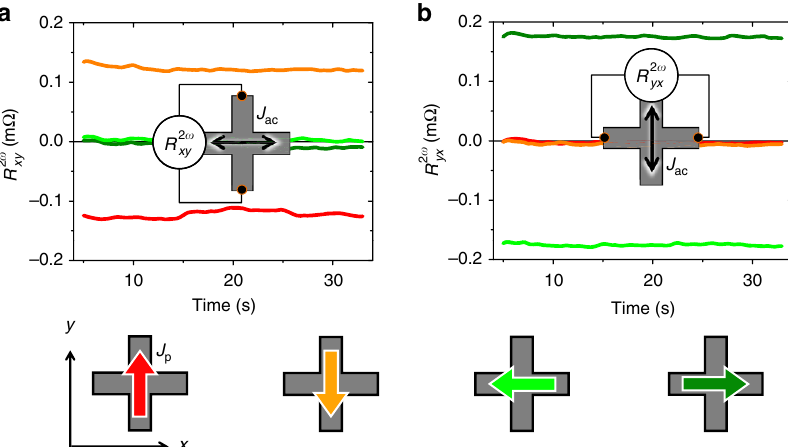
Fig. 3 Symmetry of the second-harmonic signals. a R 2 ω xy readout for a sequence of writing pulses along + y , + x , − y , − x directions. b Same as a , with R 2 ω yx readout (probing current along y axis). Readout measurements in a , b start 5 s after the writing pulse